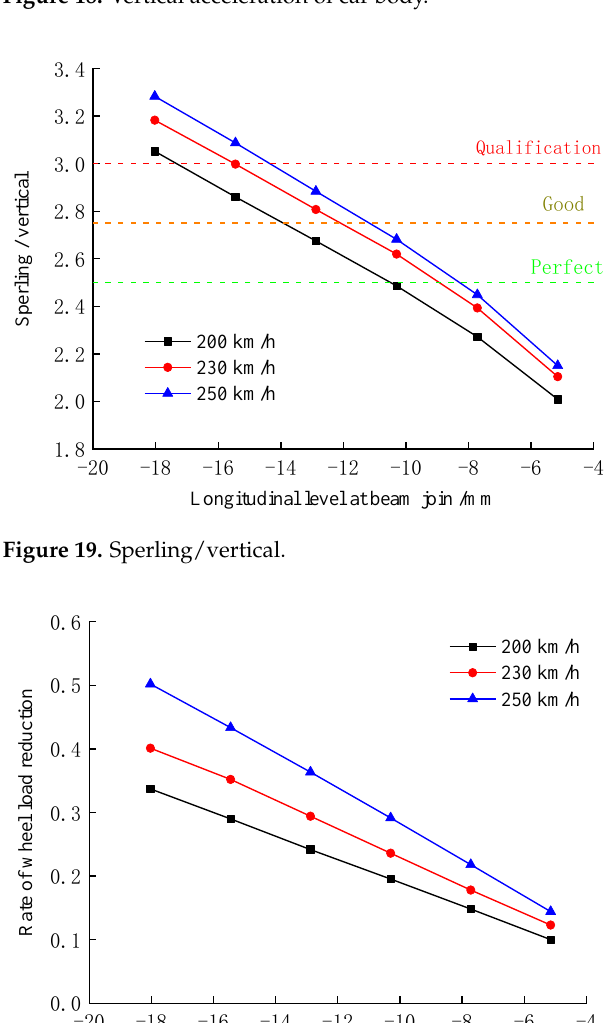
Figure 18. Vertical acceleration of car body.